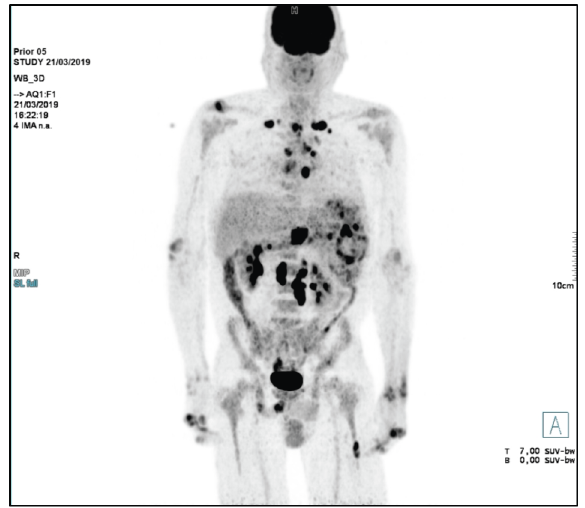
Figure 1: 18F-FDG PET/CT performed at initial presentation showing hypermetabolic involvement of the spleen and lymph nodes above and below the diaphragm, as well as small, 18F-FDG- avid pulmonary nodules and focal skeleton/bone marrow hyper- metabolic